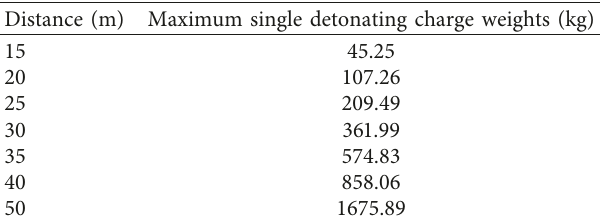
Figure 10: Relationship between vibration velocity and R Table 8: The maximum single detonating charge weights corre- sponding to different